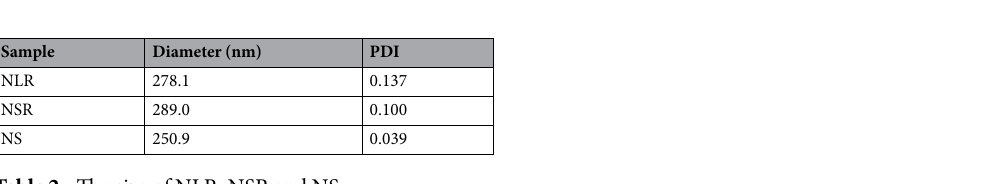
Table 2. The size of NLR, NSR and